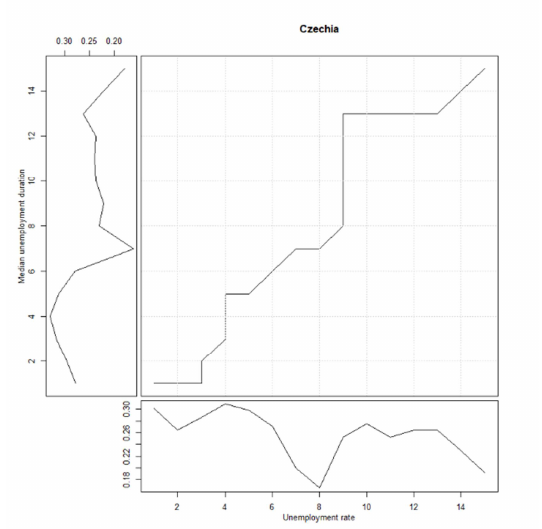
Figure 9. Alignment plots for the unemployment rate and lagged median unemployment duration for